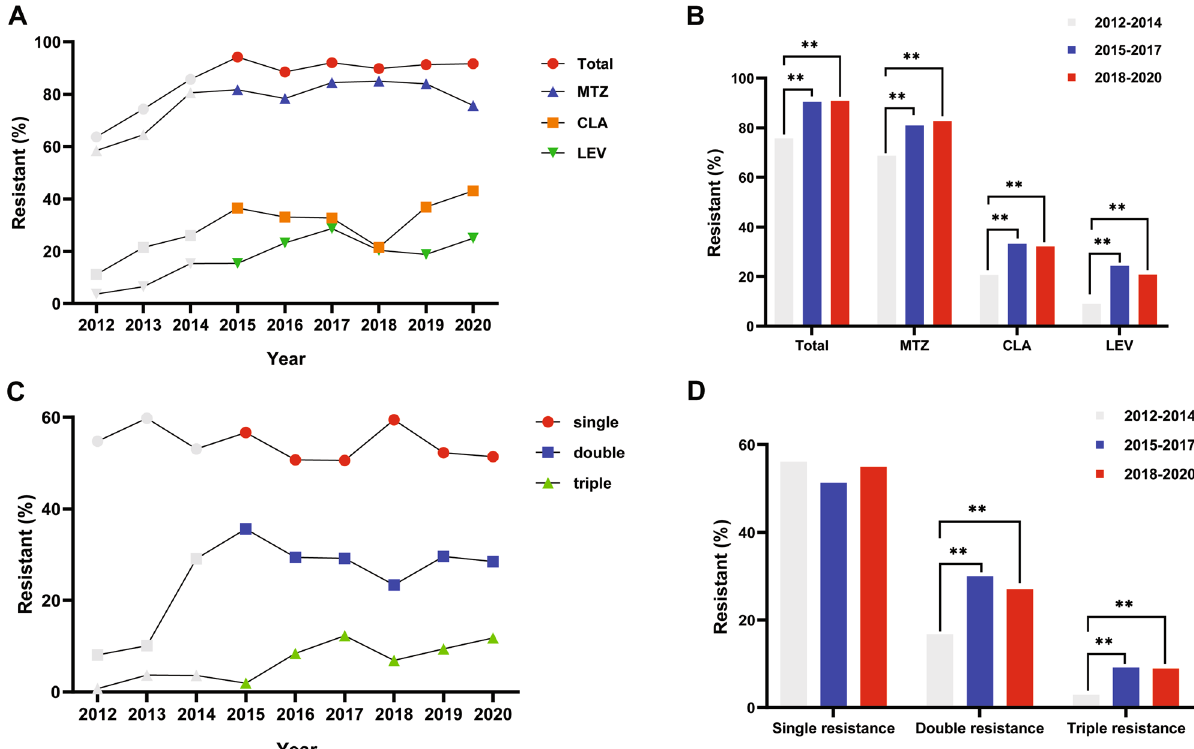
Figure 1. Antibiotic resistance of H. pylori to clarithromycin, metronidazole and levofloxacin according to year. ( A ) The total resistance and resistance to clarithromycin, metronidazole and levofloxacin annually from 2012